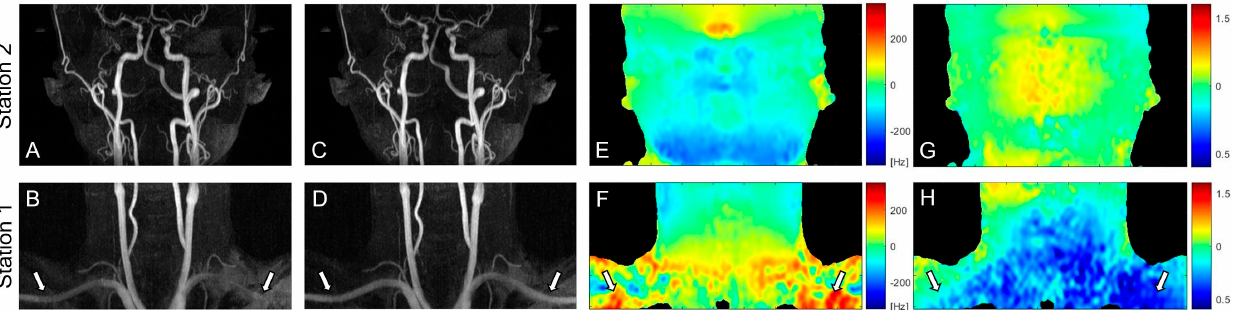
Figure 3. Coronal maximum intensity projections (MIPs) of VS-MRA images obtained using VS preparations without ( A , B ) and with pre-compensation ( C , D ), along with off-resonance maps ( E , F ) and B 1 maps ( G , H ). The original VS preparation suffers from arterial signal loss in the regions of large off-resonance and low B 1 field, whereas the pre-compensated VS preparation significantly improves the arterial visualization in the same regions (arrows). The images in station 2 ( A , C ) show little difference due to relatively low field offsets ( E , G ).